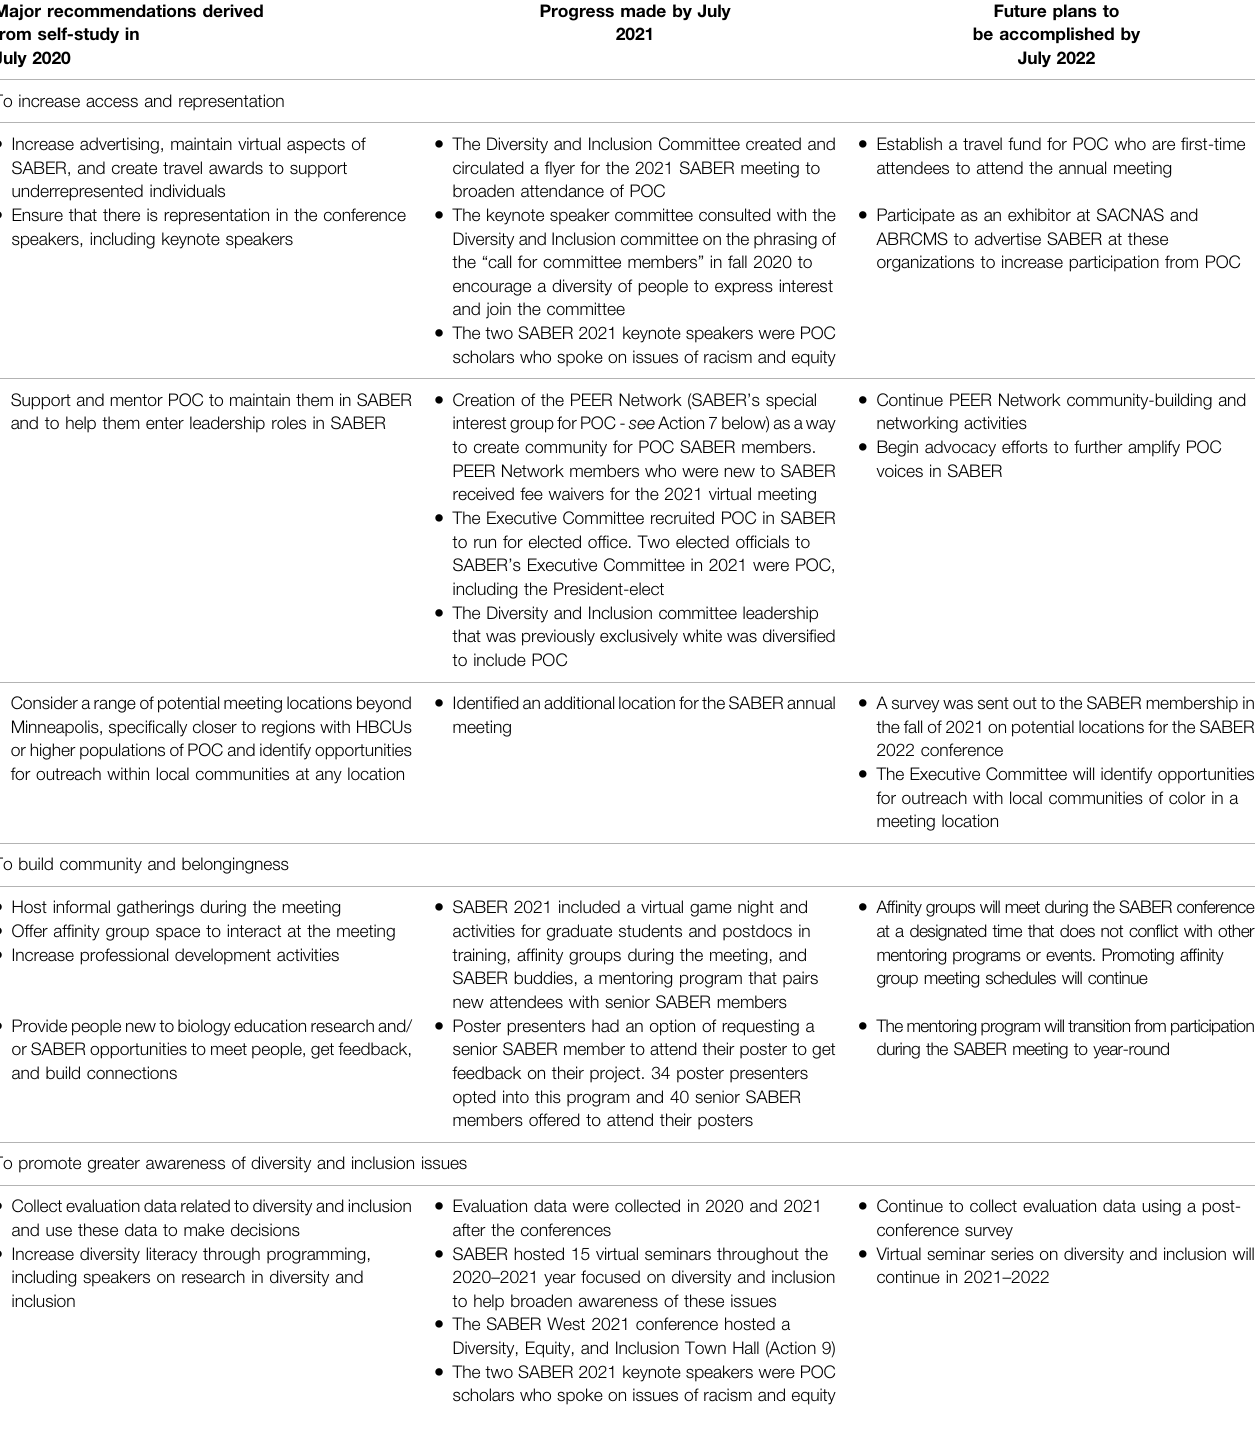
TABLE 3 | Major self-study fi ndings from July 2020, including progress to date and future plans to address recommendations. Major recommendations derived from self-study